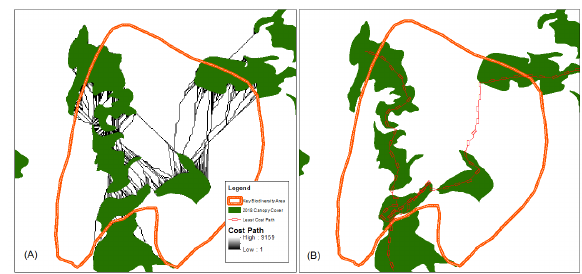
Figure 8. (A) Least cost paths and (B) Cost